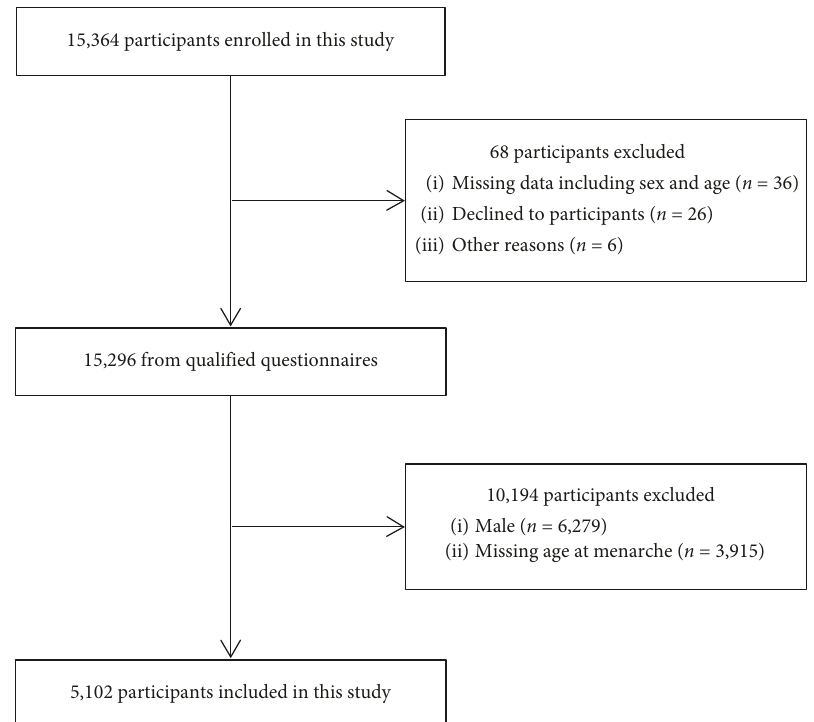
Figure 1: Flow chart of study